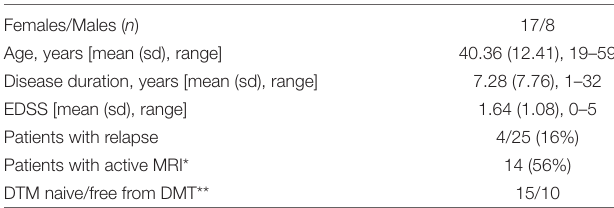
TABLE 1 | Demographic, clinical, and neuroradiological characteristics of patients at